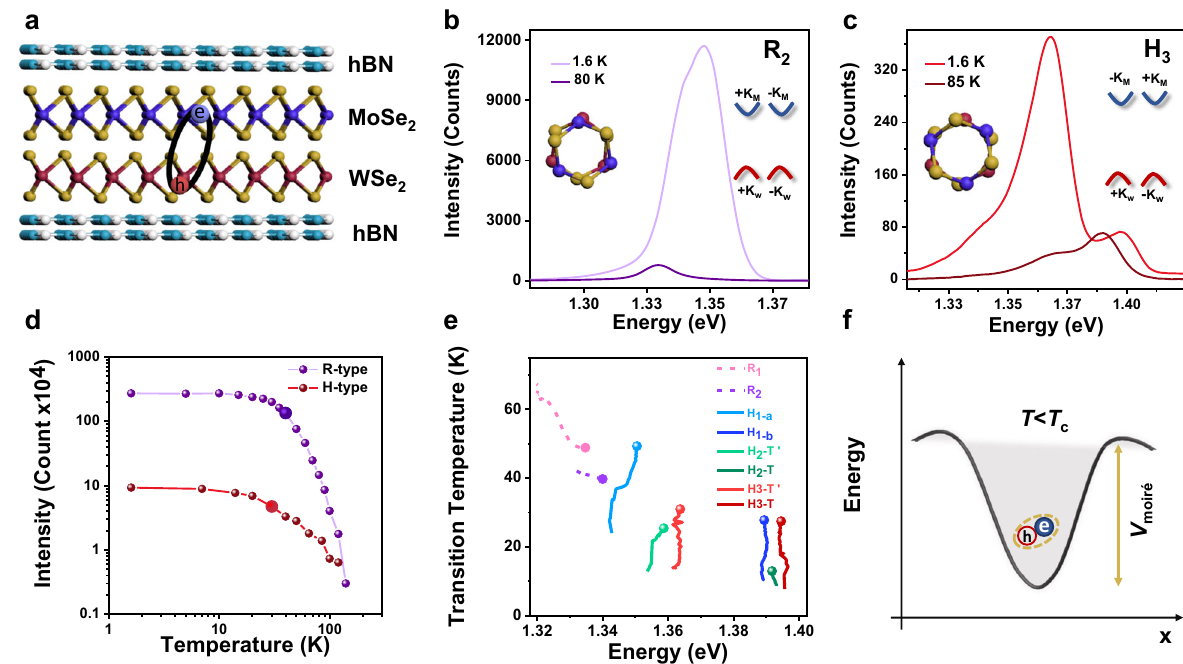
Fig. 1 Temperature-dependent PL transition from R- and H-type structures. a Cartoon depiction of hBN-encapsulated MoSe 2 – WSe 2 heterostructure showing an IX composed of an electron and hole in opposite layers. b , c Example PL spectra of R(H)-type IX at two different temperatures for fi xed excitation power 56 µW (74 µW). The left insets depict a top view of the real-space alignment. The right insets show the alignment of the valleys in momentum space. d Spectrally integrated PL of R- and H-type heterostructures as a function of temperature, showing temperature-dependent transitions at 40 and 30 K, respectively, marked by larger circles. e Energy-dependent transition temperature for fi ve different samples. The R and H subscripts label the sample number, labeled in order of increasing IX energy, where the a and b subscripts denote two disconnected sample regions of the same device. T ’ labels the lower energy triplet ’ peak, and T labels the higher energy triplet peak. The IX center energy varies with temperature and excitation power, the transition temperature is plotted for each power, and the solid dot marks the transition temperature for the highest excitation power. f Cartoon of IX trapped in moiré potential ( V moiré ) below a transition temperature ( T c ). Excitation wavelength is 670 nm, and the confocal collection diameter is 1